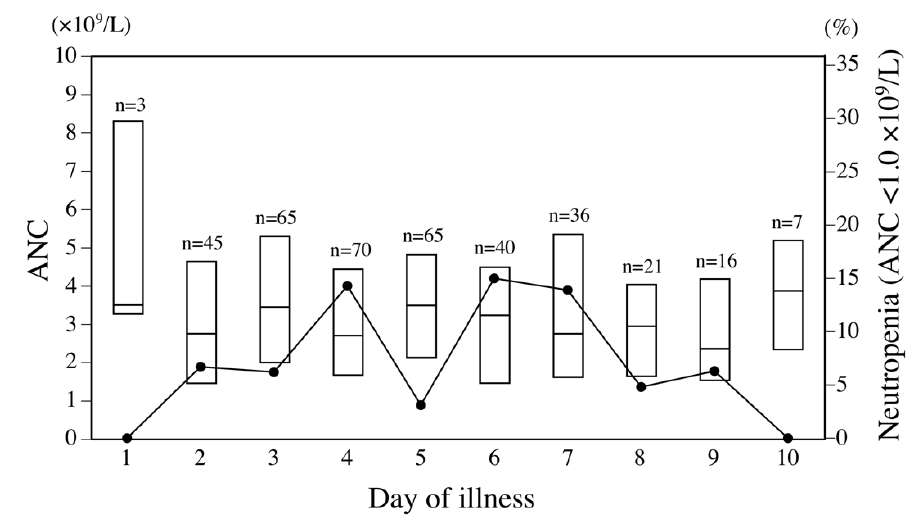
Figure 1. Distribution of absolute neutrophil count (ANC) and proportion of neutropenia <1.0 × 10 9 /L in respiratory syncytial virus (RSV)-infected infants according to day of illness. Each box bounds the interquartile range of ANC, divided by the median. Solid line denotes the proportion of neutropenia.